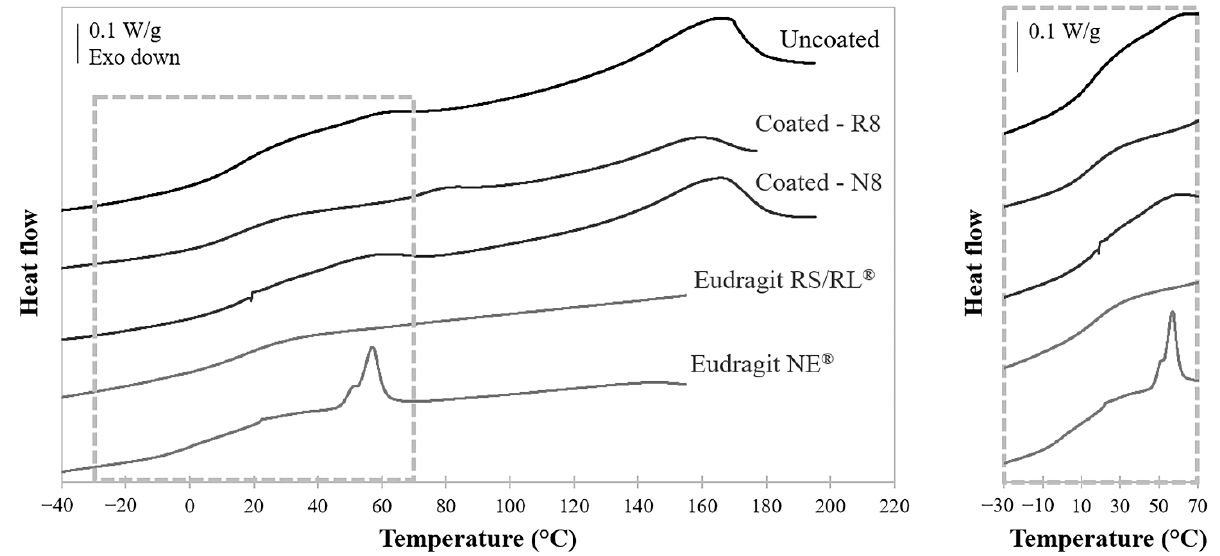
Figure 5. Thermograms of uncoated and coated (i.e., R8 and N8) samples, and of free Eudragit ® RS/RL and Eudragit ® NE films; the insert is a magnification of the glass transition